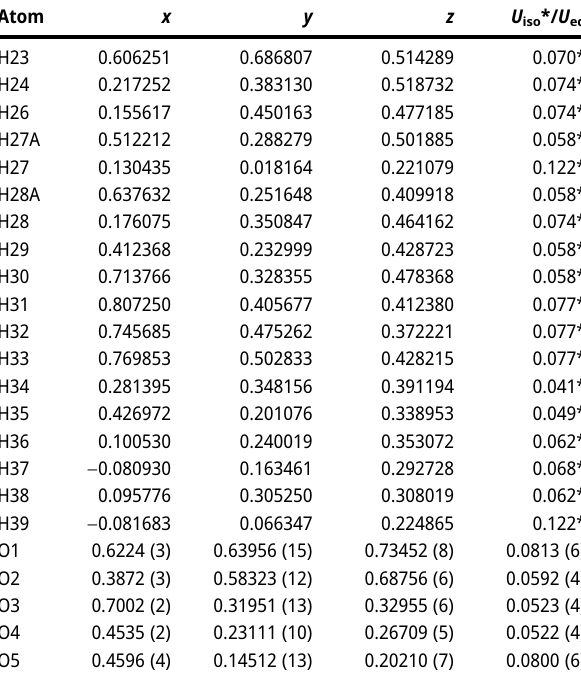
Table  : Fractional atomic coordinates and isotropic or equivalent isotropic displacement parameters (Å 